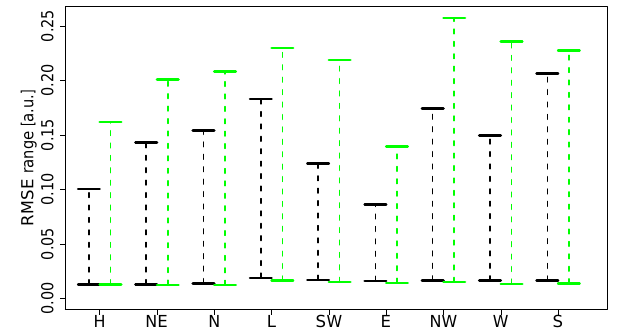
Figure 9. As Fig. 8 but for the RMSE normalised to the average